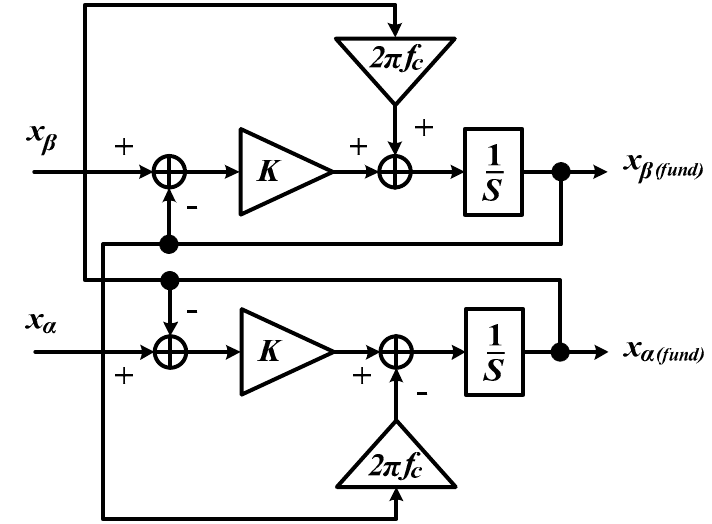
Figure 6. Basic structure of self-tuning filter tuned at specific f c [76,77].